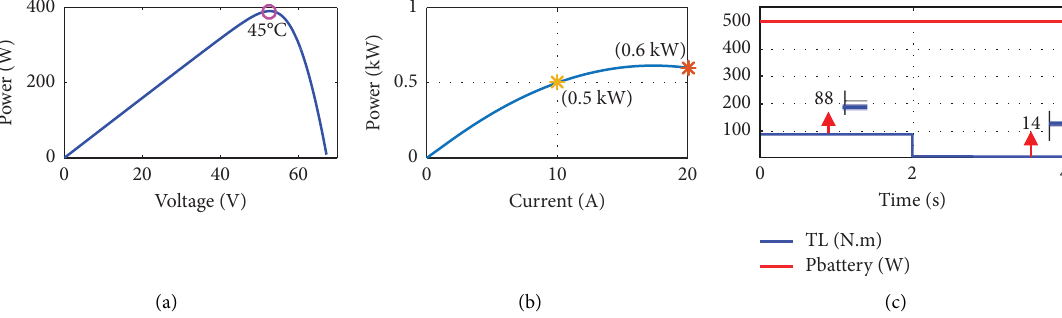
Figure 19: System inputs in the second operation mode. (a) PV characteristic. (b) FC characteristic. (c) Torque and nominal power of the battery.